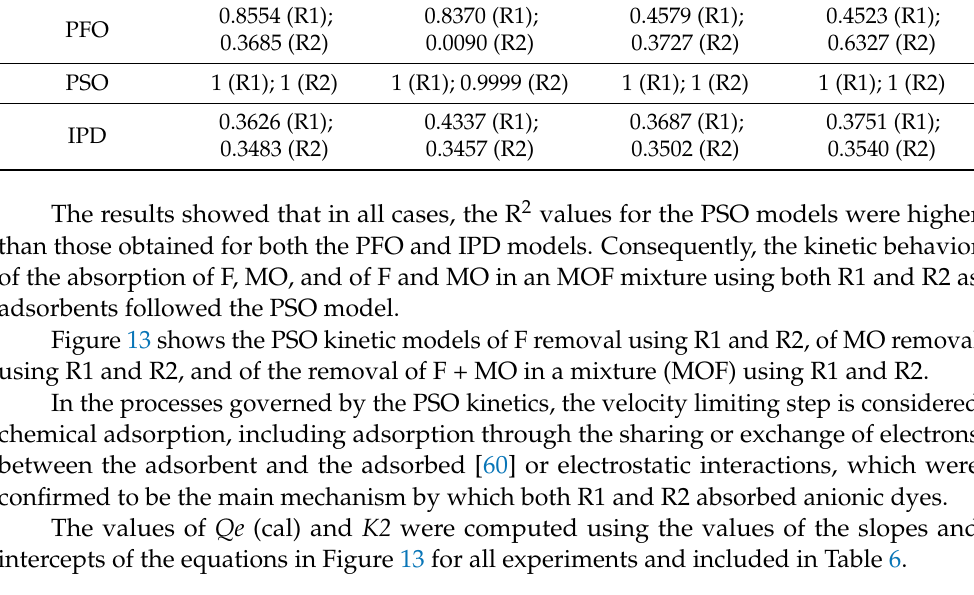
Table 6. Values of Qe (cal) and K